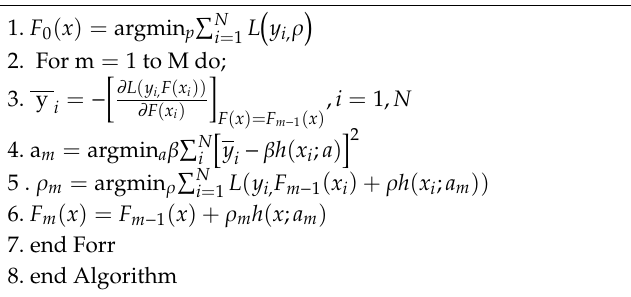
Algorithm 1: Gradient Boosting Regression Tree (GBRT)